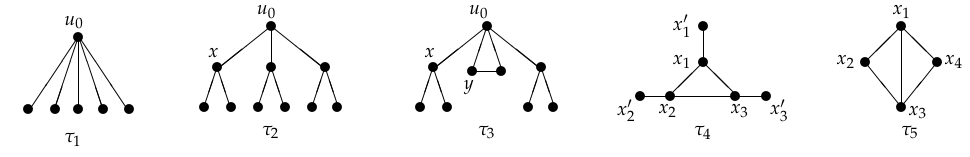
Figure 1. Five 3-cutwidth critical